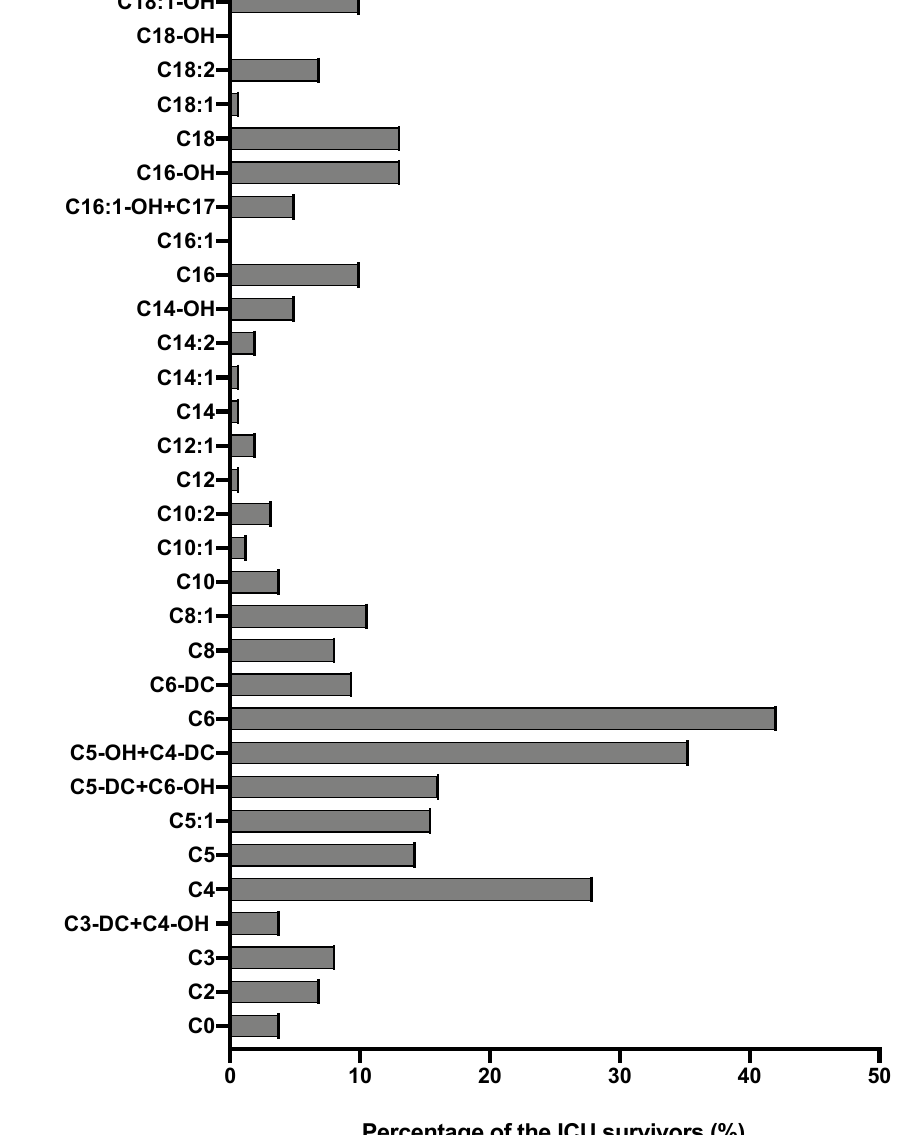
Figure 2. Proportion of ICU survivors with acylcarnitines concentrations above percentile 97.5 of the reference adult